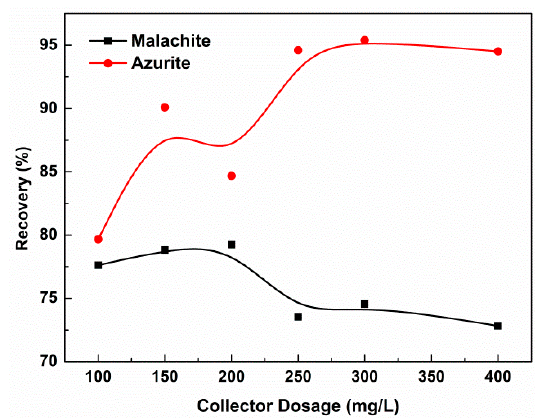
Figure 3. The recovery of copper oxide ore under conditions of different collector dosage (pH = 8.5).